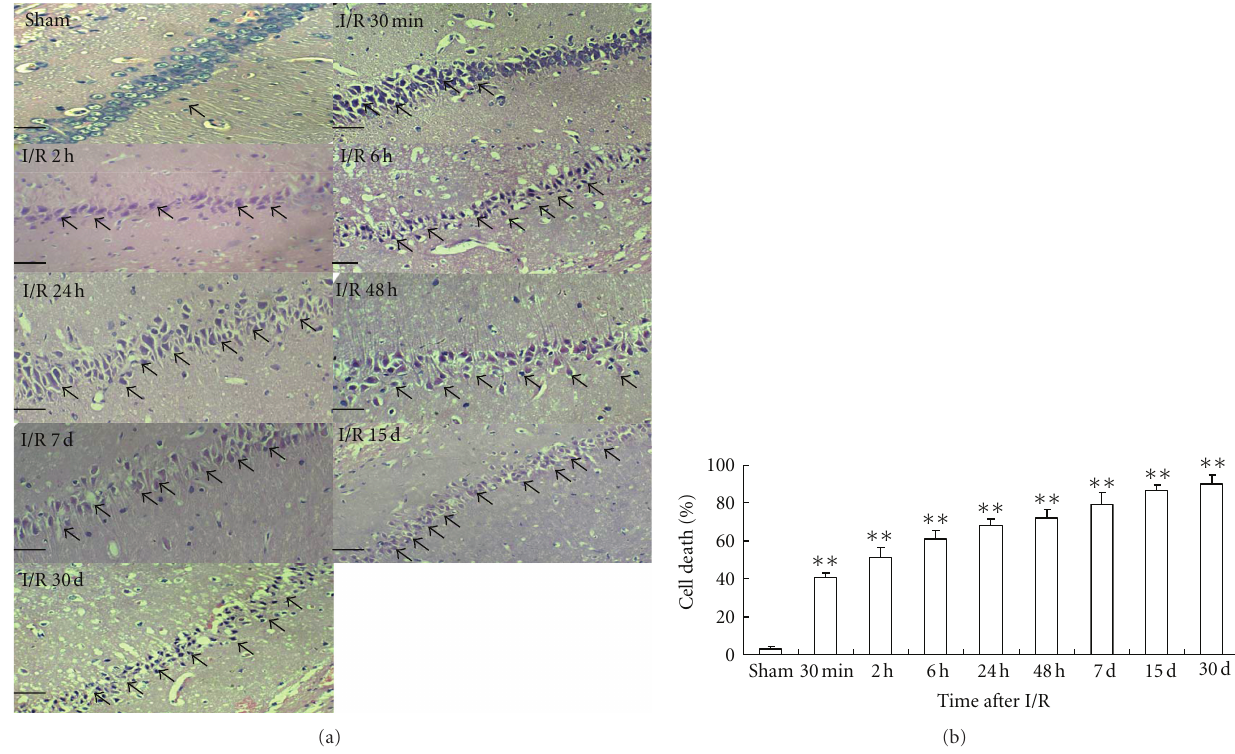
Figure 1: Morphological change of rat hippocampal neurons induced by I/R. (a) Representative pictures of H&E stained CA1 section, 400x. Scale bars = 50 μ m. (b) Group data showing the cell death rate. ∗∗ P < 0 . 01 compared with vehicle sham group ( n =